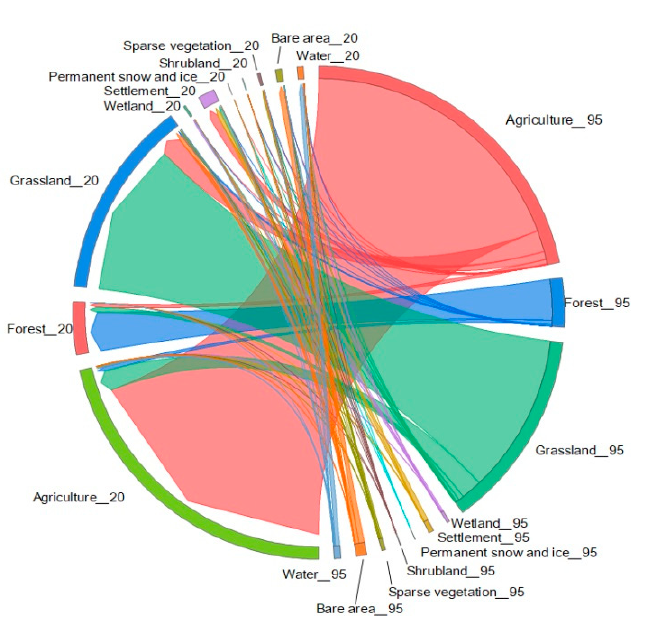
Figure 6. Land cover change in GYRR from 1995 to 2020 using a Chord diagram expression. The right semicircle shows the proportions of different land covers in 1995, and the left semicircle shows the proportions of different land covers in 2020. The arrows in the circle indicate the land cover change.